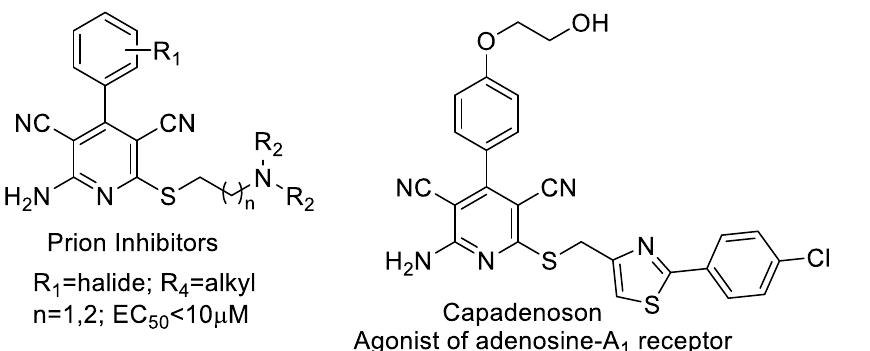
Figure 1. The 2-amino-4-aryl-3,5-dicarbonitrile-6-sulfanylpyridines as medicinally privileged